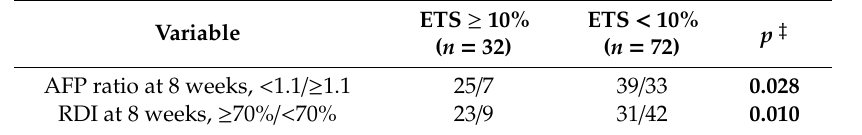
Table 2. Correlation of early tumor shrinkage with AFP response and relative dose intensity †